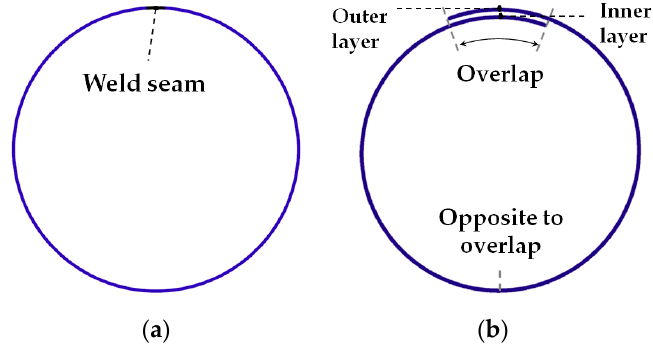
Figure 2. Shape of cross-sections: ( a ) tube blank; ( b ) overlapping blank.